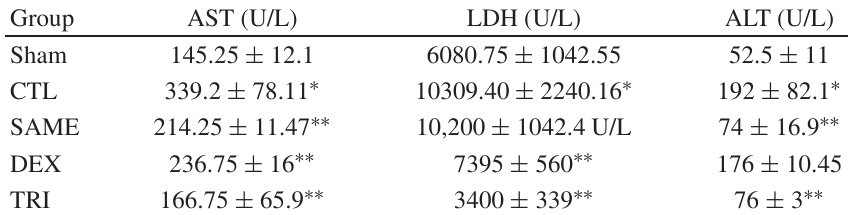
TABLE 1: Serum biochemical parameters: AST, LDH, and ALT